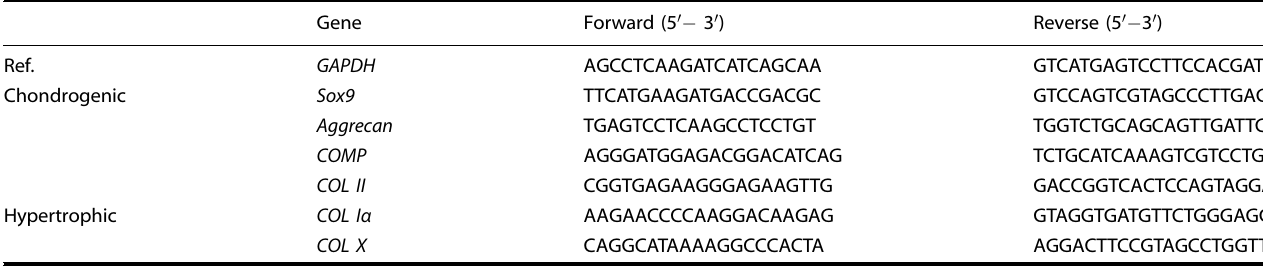
Table 2. Primer sequences used for RT-PCR procedures.